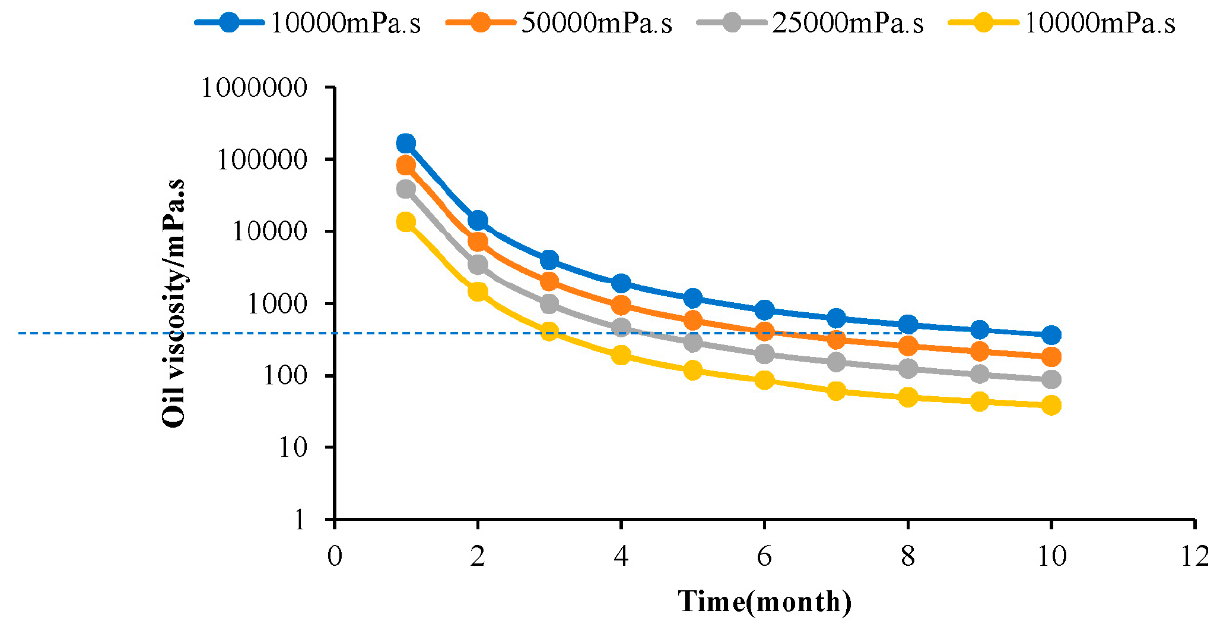
Figure 10. Oil viscosity in the inter-well region with time.